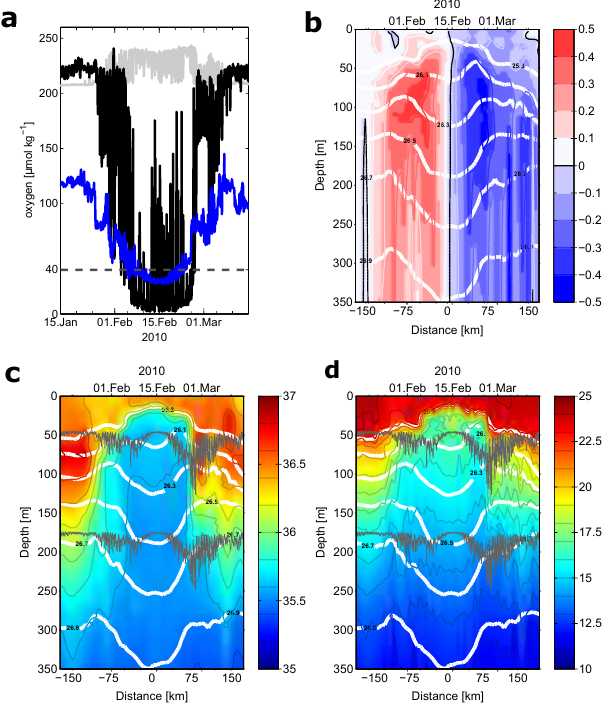
Figure 3. (a) Time series of DO from the two sensors available at nominal 42m(black line) and 170mdepth (blue line). For refer- ence, the oxygen surface saturation (grey line) and the 40µmolkg − 1 threshold (black broken line) are shown. Corresponding time series of (b) meridional flow (ms − 1 ), (c) salinity (in PSS-78), and (d) potential temperature ( ◦ C) in the upper 350m as observed during the CVOO2010 passage are shown. The black line in (b) indicates zero meridional velocity, and the grey lines in (c) and (d) indicate the varying depth of the oxygen sensors shown in (a) during in- stalment. Selected potential density anomaly surfaces are shown as white contours in (b) , (c) and (d) for reference, and the time se- ries data were converted into distance assuming an eddy translation speed of 5kmday − 1 .